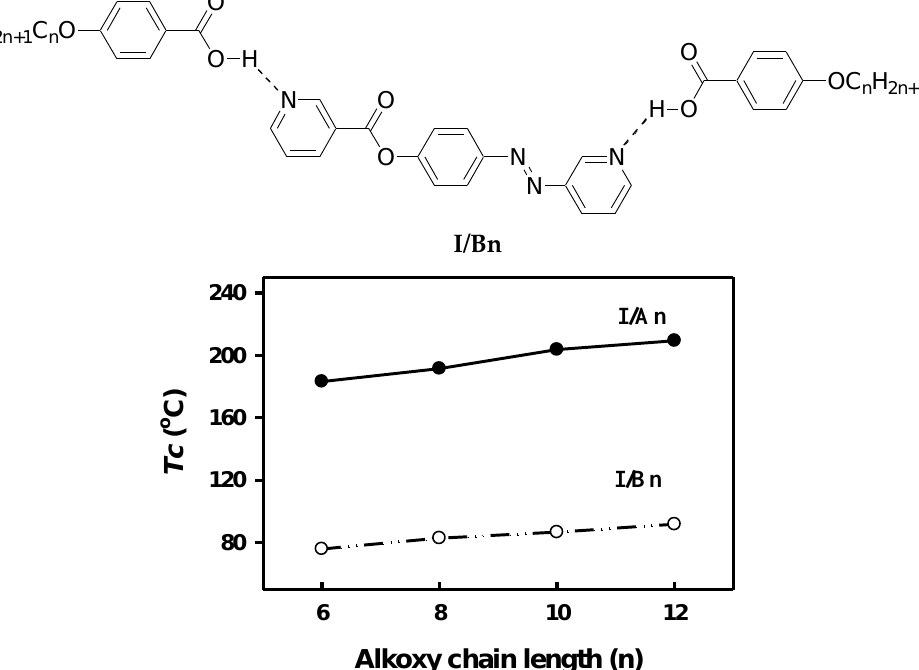
Figure 8. Comparison between present SMHB complexes I/An (●) and five-ring complexes I/Bn ( ○ ) in thermal mesophase stability.